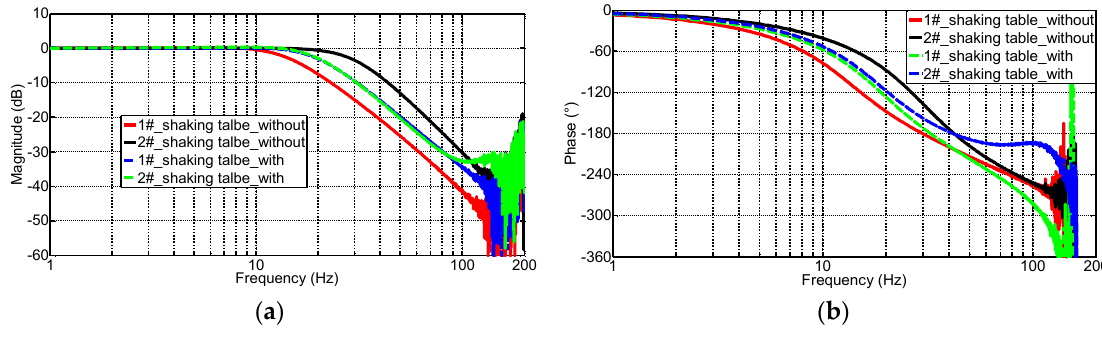
24 of 31 Figure 19. The reference signal. ( a ) Time domain; ( b ) Frequency domain. ( a ) ( b ) Figure 20. Synchronization errors under random signal. ( a ) Time domain; ( b ) Frequency domain. Table 5. Synchronization errors under random signal. Controller